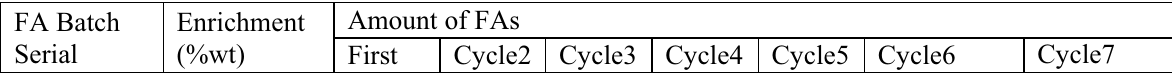
Table V. : FAs Usage of Boron-Free